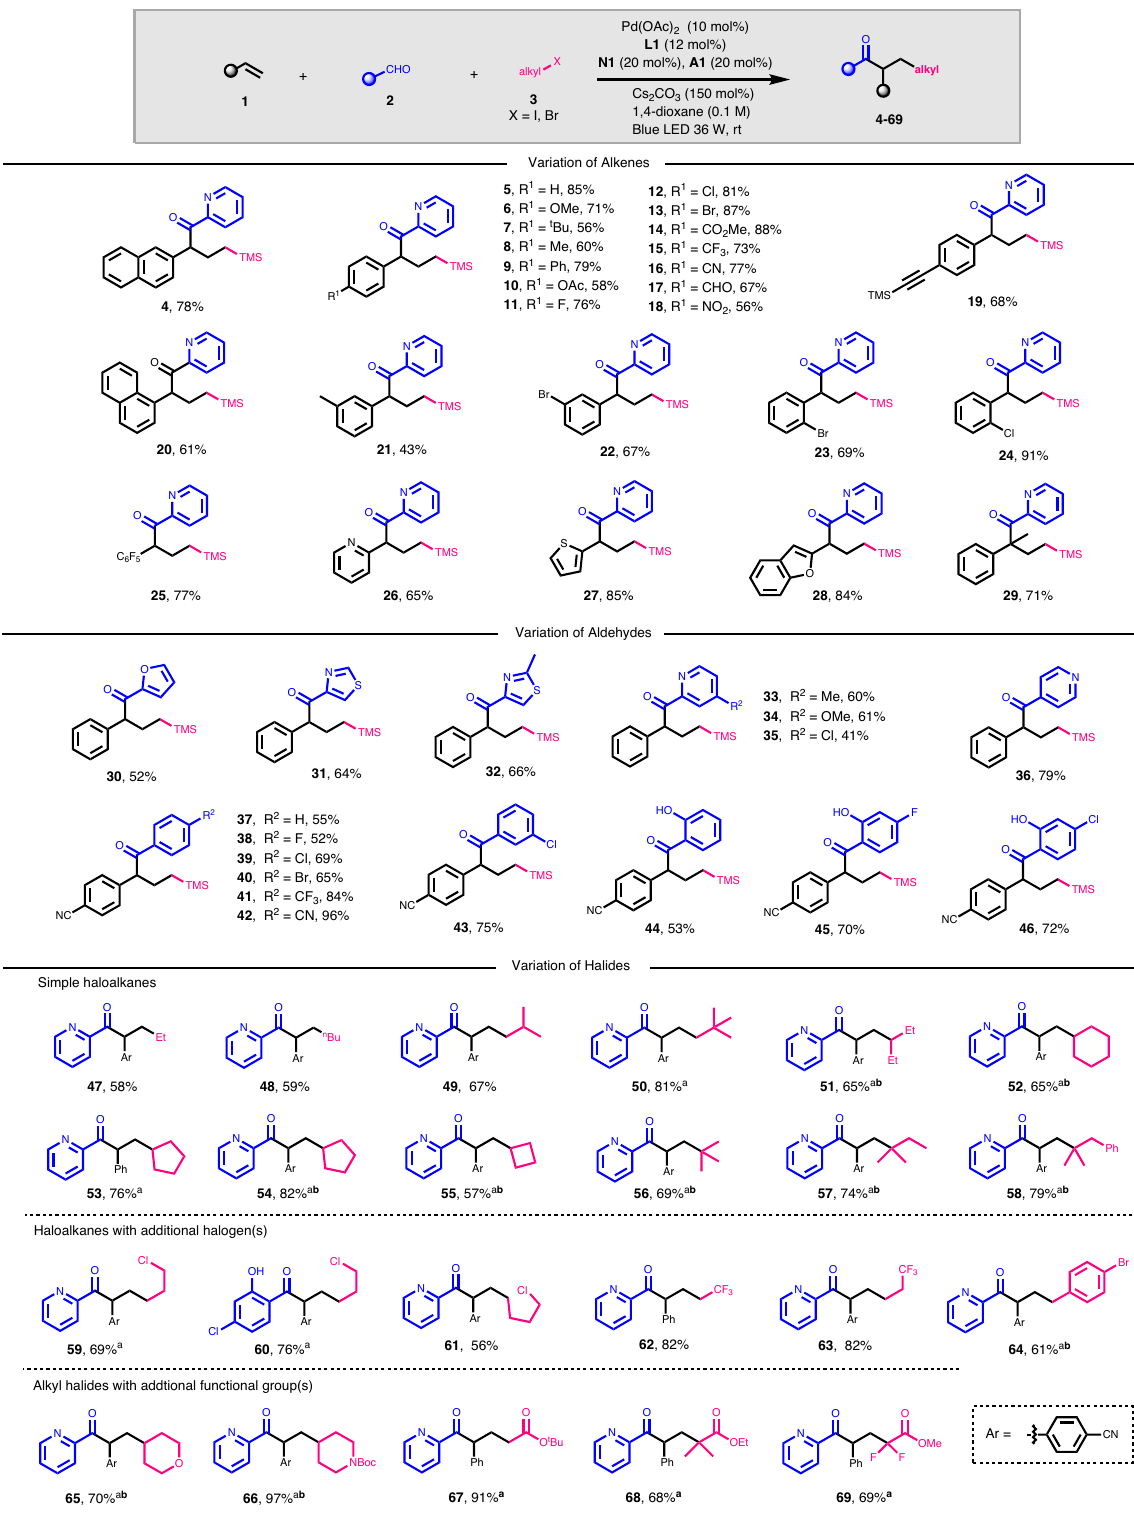
Fig. 2 | Substrate scope for alkylacylation of alkenes. Reaction conditions: 1 (0.20mmol), 2 (0.40mmol), 3 (0.3mmol), Pd(OAc) 2 (10mol%), L1 (12mol%), N1 (20mol%), A1 (20mol%), Cs 2 CO 3 (150mol%), 2.0mL 1,4-dioxane, rt, blue LED